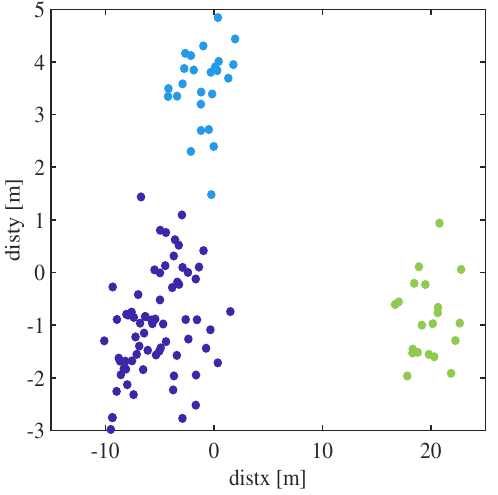
Figure 4. Initial clustering